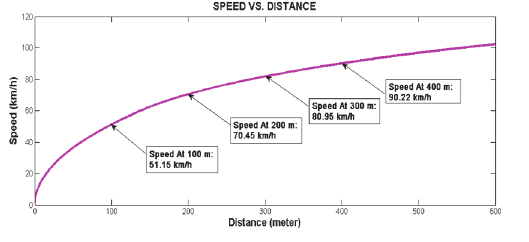
Fig 6. Speed versus distance plot.